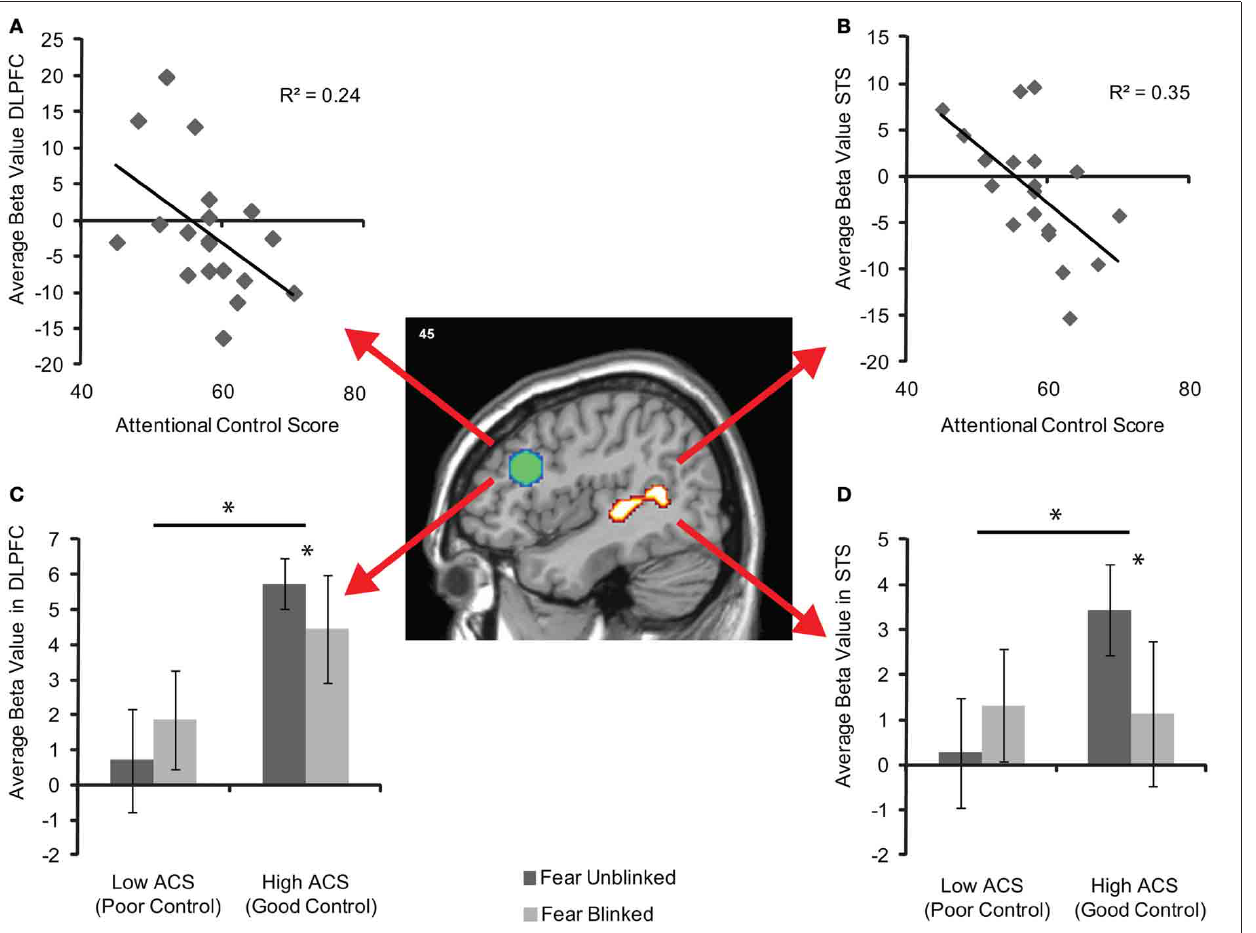
FIGURE 4 | Brain activity in the independently-definedDLPFC (green sphere based on previous coordinates) and STS (activity cluster based on localizer scan) regions of interest for fear blinked > unblinked trials. (A) Shows average unstandardized beta values in DLPFC, and (B) in STS,